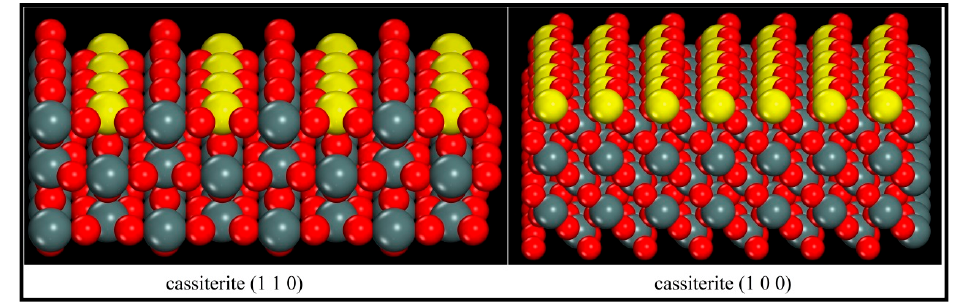
Figure 6. Optimized cassiterite (110) and (100) surfaces (colour codes: Gray—Sn, Red—O, Yellow—surface Sn).